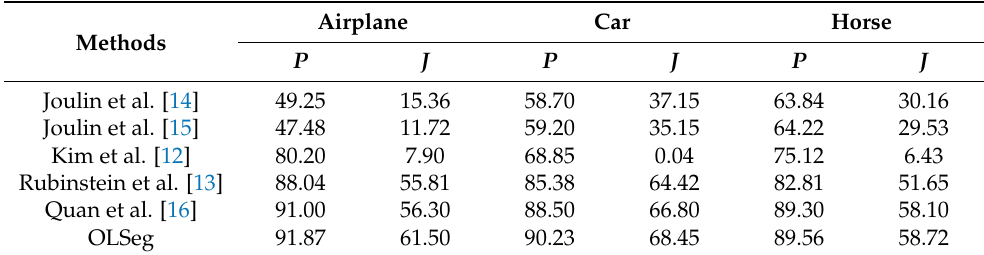
Table 3. Comparisons of P and J (%) on the Internet dataset. The P and J denote the precision and Jaccard similarity